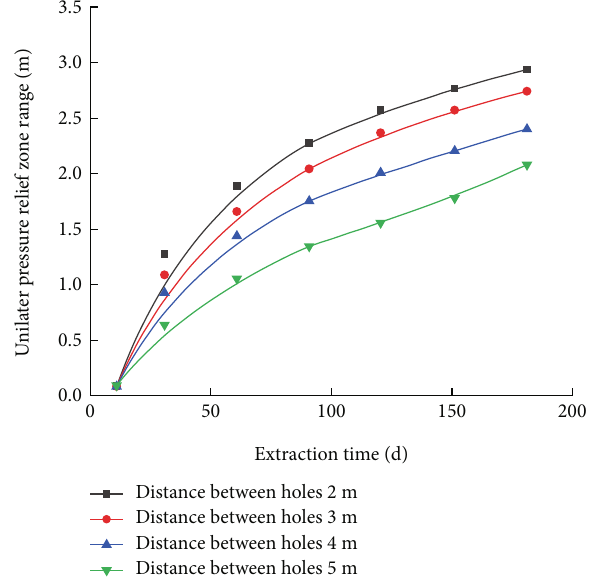
Figure 15: Relationship between pressure relief range and time under di ff erent hole arrangement in double-hole fracturing.